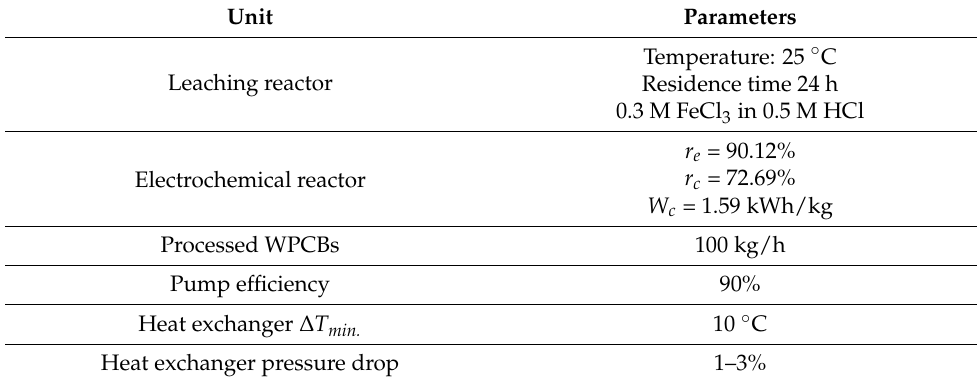
Table 9. Model assumptions and input data